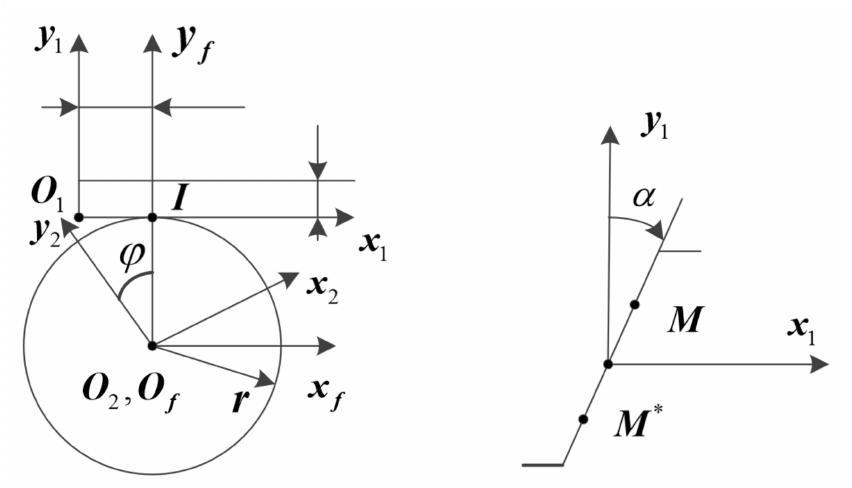
Figure 1. Machining coordinate system of profile-shifted pinion and profile-shifted